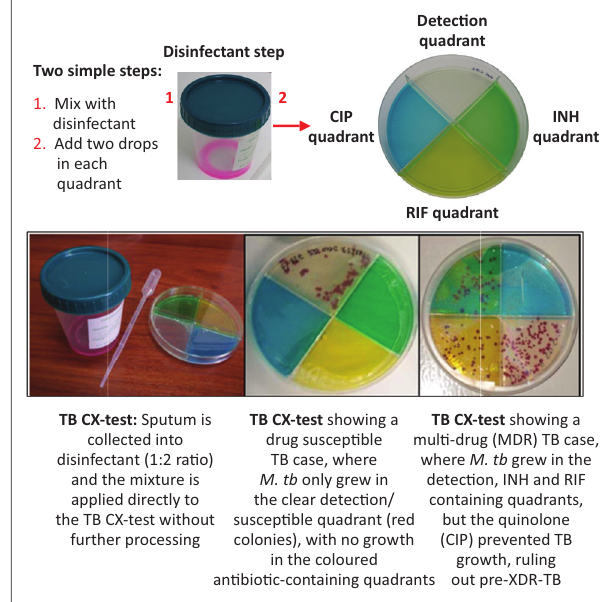
FIGURE 1: The tuberculosis